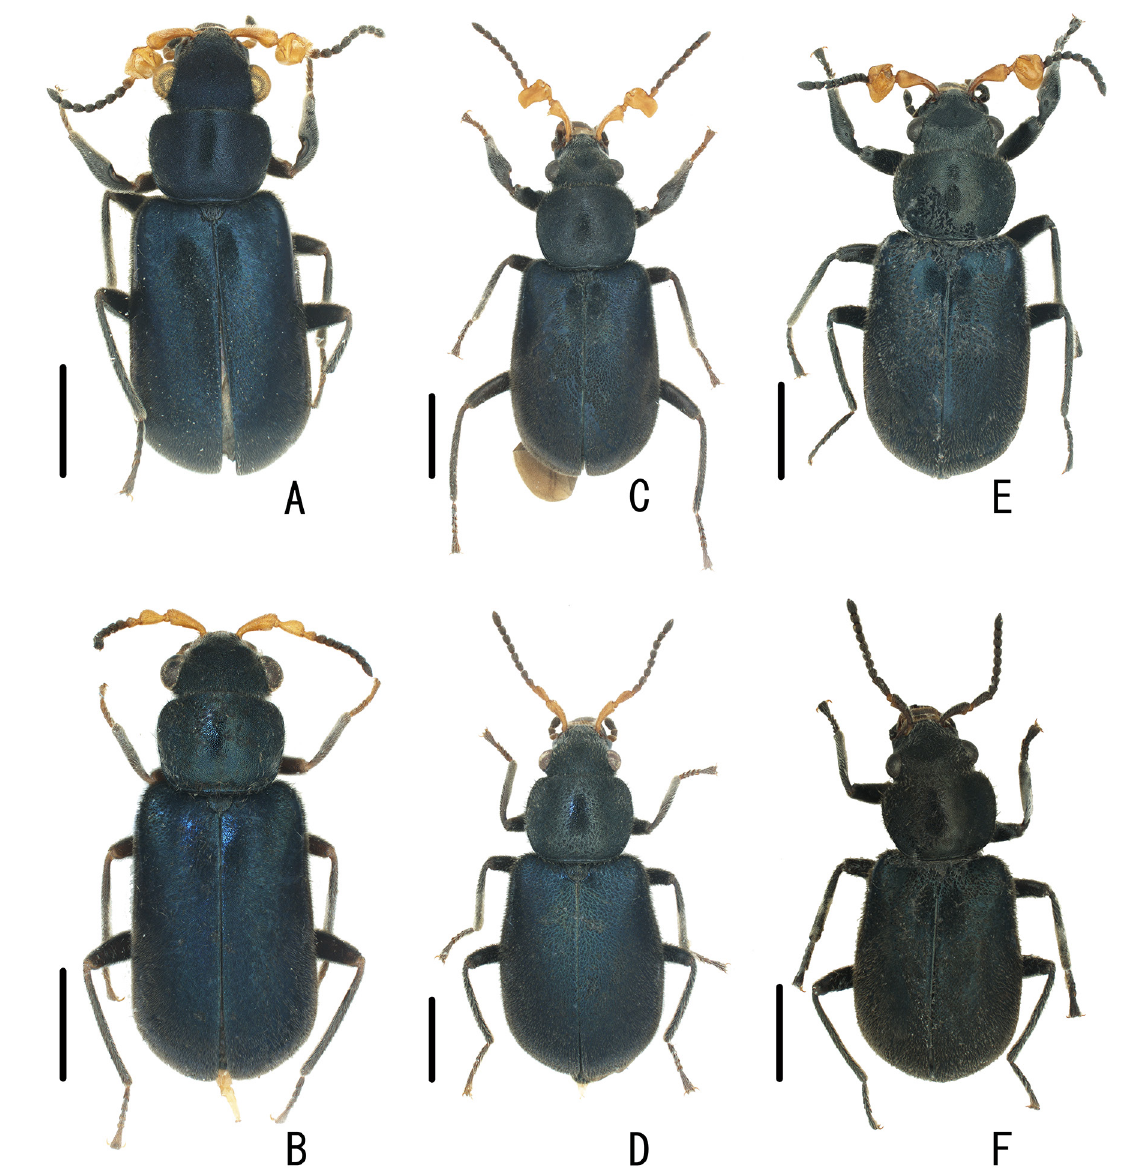
Fig. 5. Dorsal habitus of Laius spp. of ♂ (holotypes A, C, E) and ♀♀ (paratypes B, D, F). A–B .